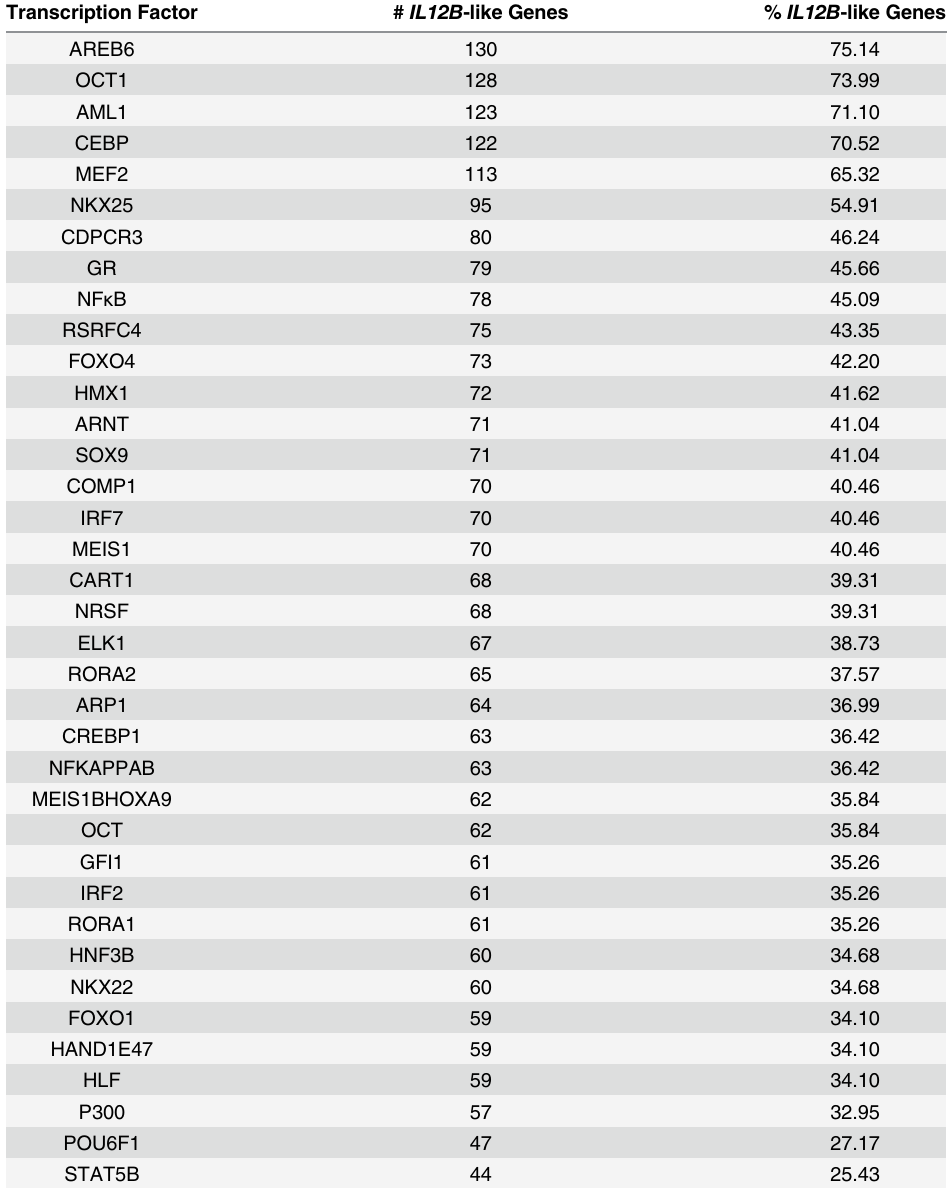
Table 3. Enriched Transcription Factor Binding sites in IL12B -like gene